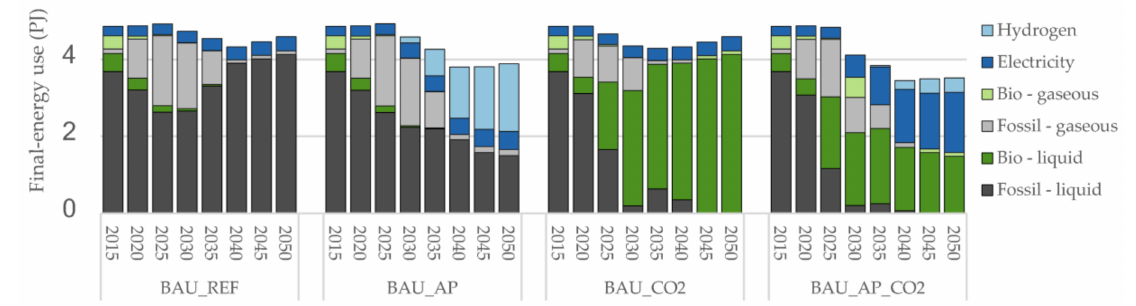
Figure 4. Total stock of buses, medium-sized goods vehicles (MGVs) and heavy goods vehicles (HGVs) in the Business-as- usual (BAU) scenarios (‘000s). Note : HFCV = hydrogen fuel cell vehicle; BEV = battery electric vehicle; PHEV = plug-in hybrid electric vehicle; CI + HEV = Conventional + non-plug-in hybrid electric compression ignition (CI) vehicle; SI + HEV = Conventional + non-plug-in hybrid electric spark ignition (SI) vehicles.